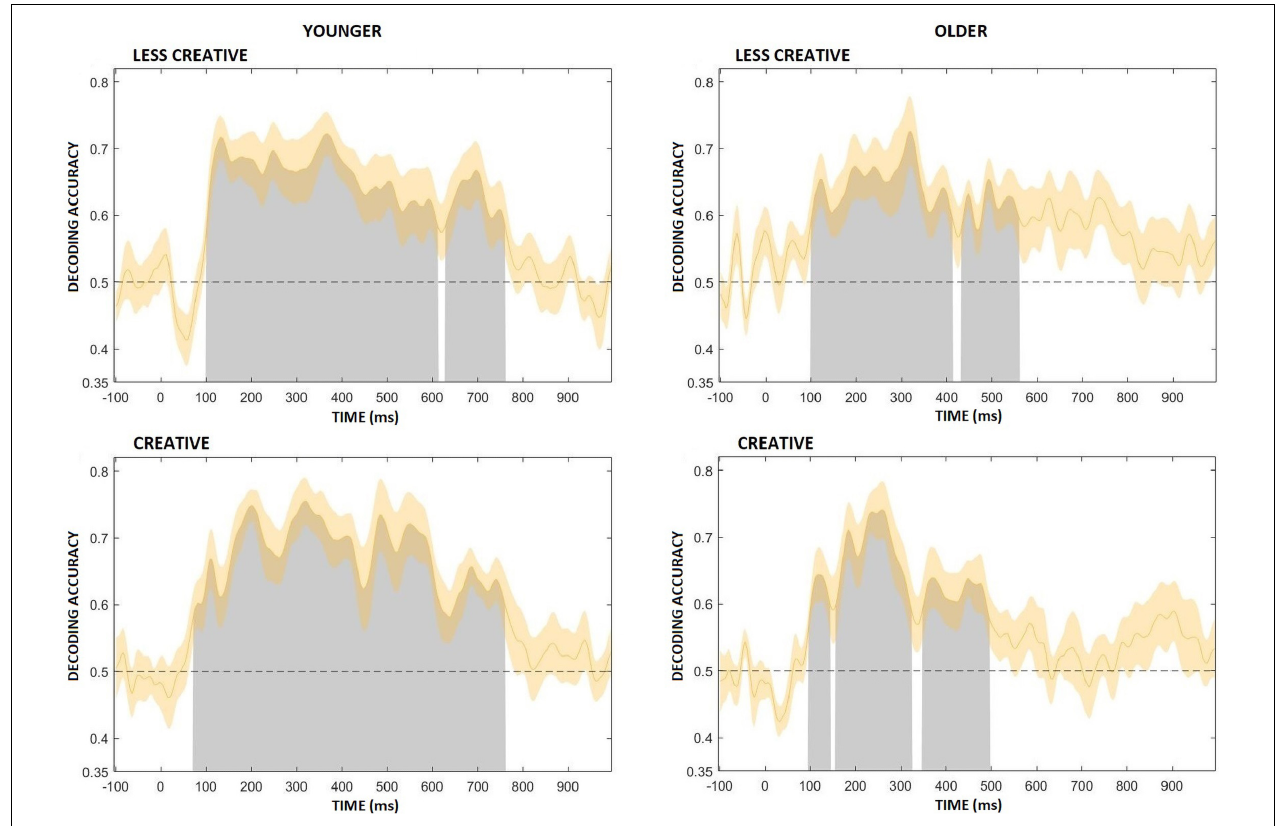
FIGURE 9 | Average decoding accuracy (averaged across participants) for the four groups (younger – less creative, younger – creative, older – less creative, older – creative). Chance level performance (0.5) is indicated by the black horizontal dashed lines. Gray areas indicate clusters of time points in which the decoding was significantly greater than chance. The orange shading indicates ± 1